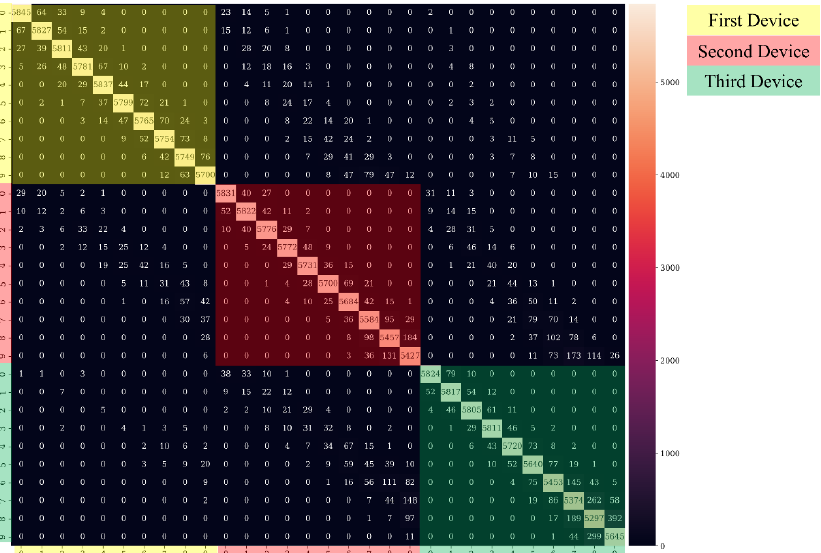
Figure 7. The confusion matrix corresponding to classification performed using a neural network trained on a dataset with 30-component output vectors. The data correspond to ten transmission eigenchannels of three devices with three different scattering strengths N s . This classification allows for identification of both the eigenchannel as well as the disorder strength. The ports corresponding to the respective three devices are color coded. The maximum value in any cell can be 6000.